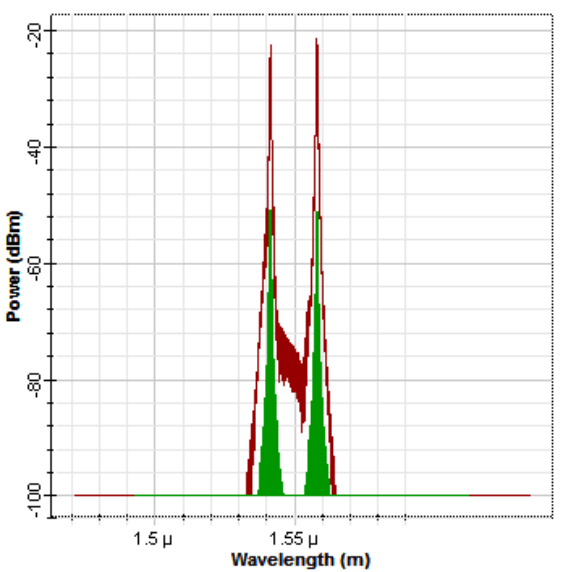
Figure 8. XOR gate output in the spectral domain.